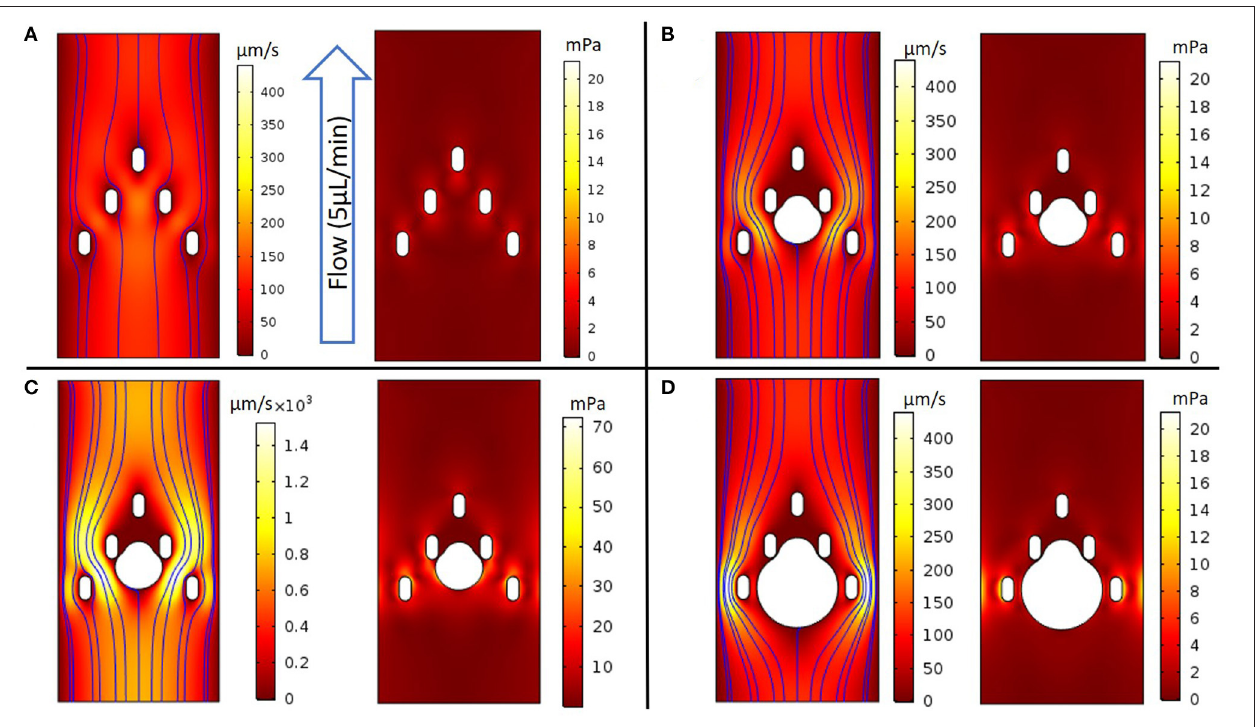
FIGURE 3 | COMSOL models evaluating fluidic properties around the device’s capture geometry. (A) (Left panel) 2D colorized analysis of velocity intensity with streamlines, (Right panel) 2D colorized analysis of shear stress without a spheroid; (B-D) (Left panel) 2D colorized analysis of velocity intensity and (Right panel) 2D colorized analysis of shear stress with spheroids of diameter as noted. (B) Capture geometry with a 300 µ m diameter spheroid perfused at a 5 µ L/min flow rate; (C) The flow rate was increased until the healthy threshold limit of 0.04Pa was observed at a 30 µ L/min flow rate; (D) Capture geometry with a 500 µ m diameter spheroid at a 5 µ L/min flow